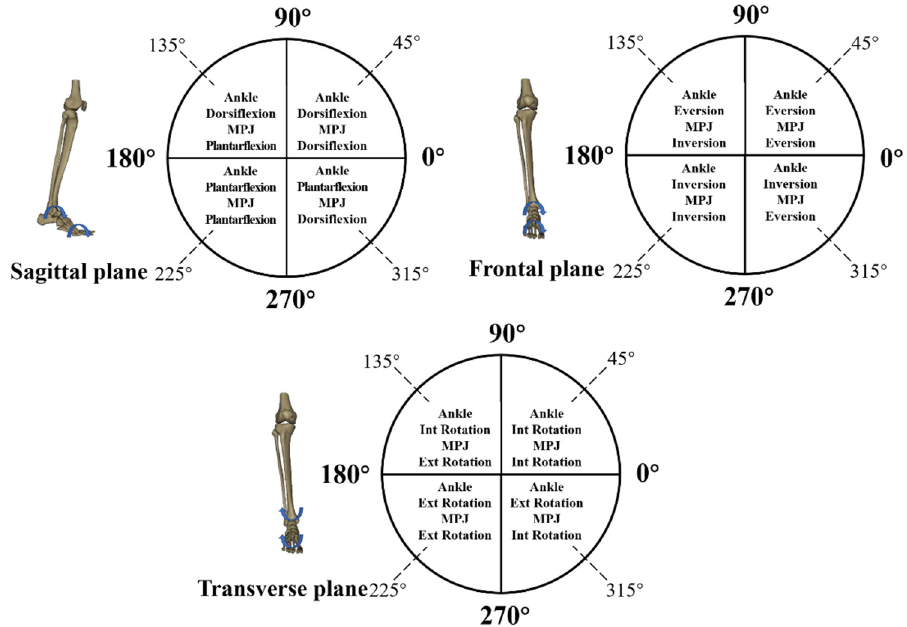
Figure 3. Classification of coordination model based on the coupling angle in sagittal, frontal, and transverse planes.